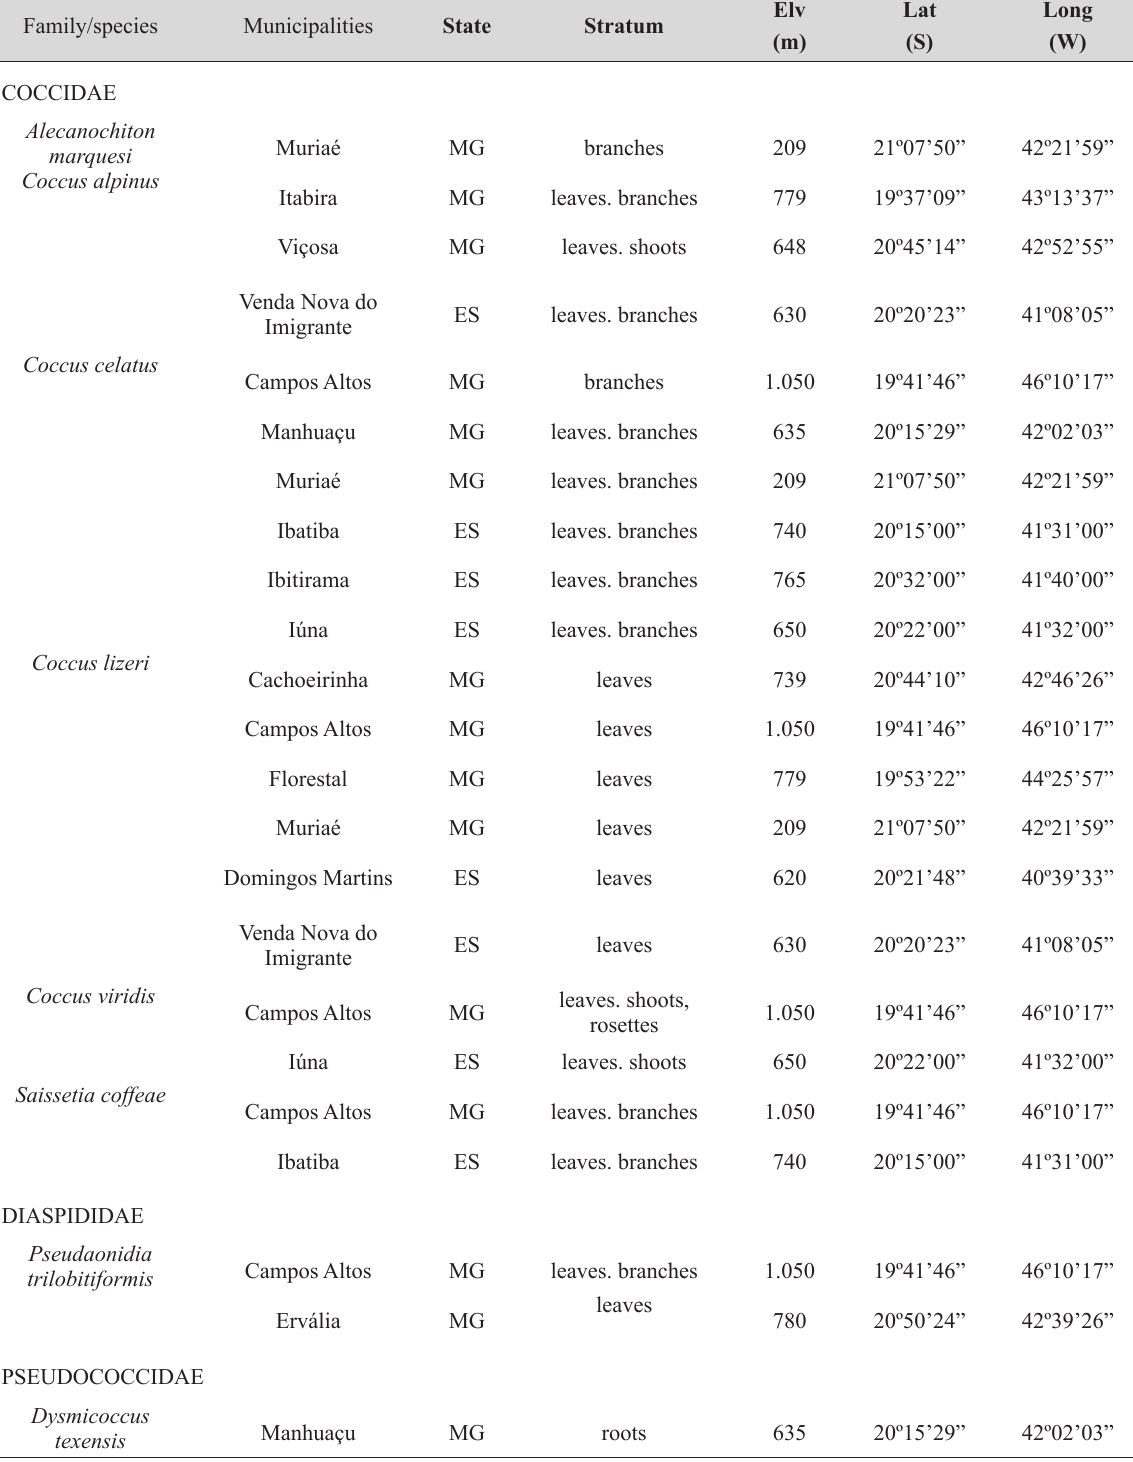
Families and scale insect species (Hemiptera: Coccoidea) collected in Coffea arabica L., and respective municipalities, elevations (Elv), latitude (Lat), and longitude (Long), States of Espírito Santo (ES) and Minas Gerais (MG), Brazil,